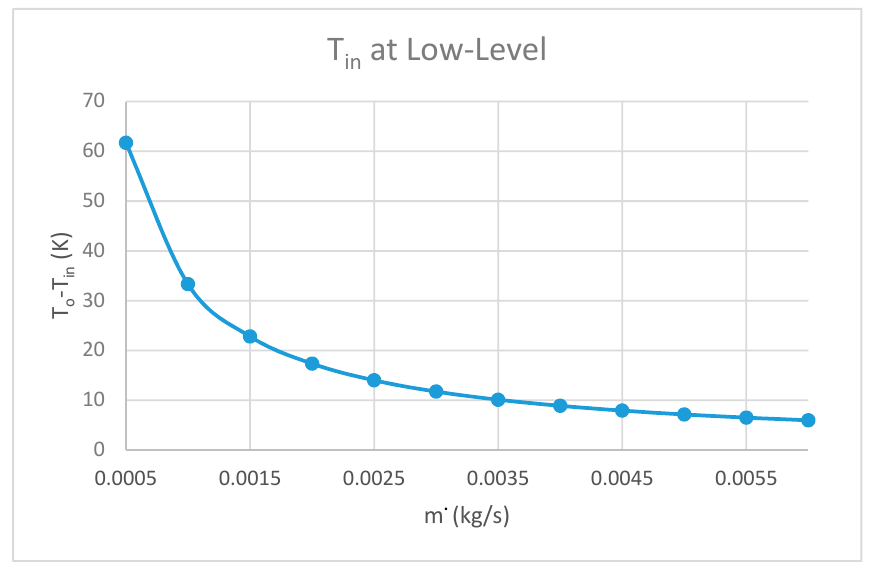
Figure 8. The effect of inlet flowrate on the outlet water temperature raise at Low-Level inlet Figure 8. temperature. inlet temperature.